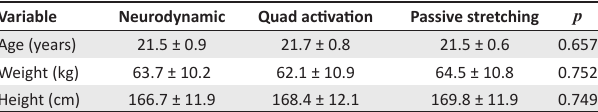
TABLE 1: Demographic characteristics by study group ( n = 60).